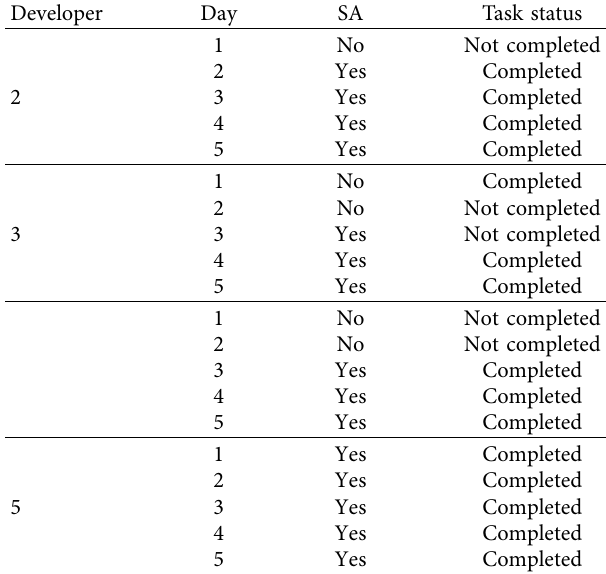
Table 7: Effect of self-assessment on task